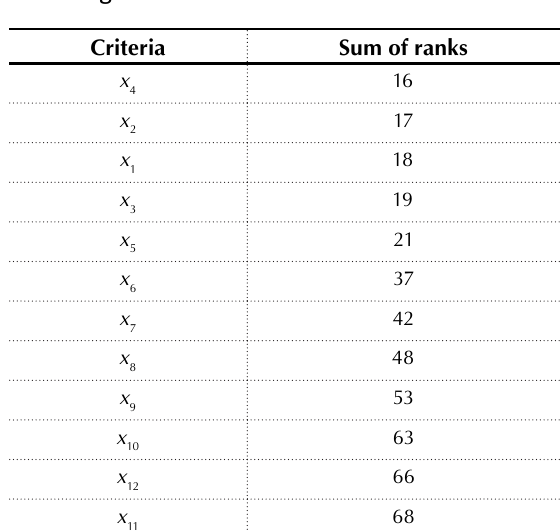
Table 7. Distribution of criteria in